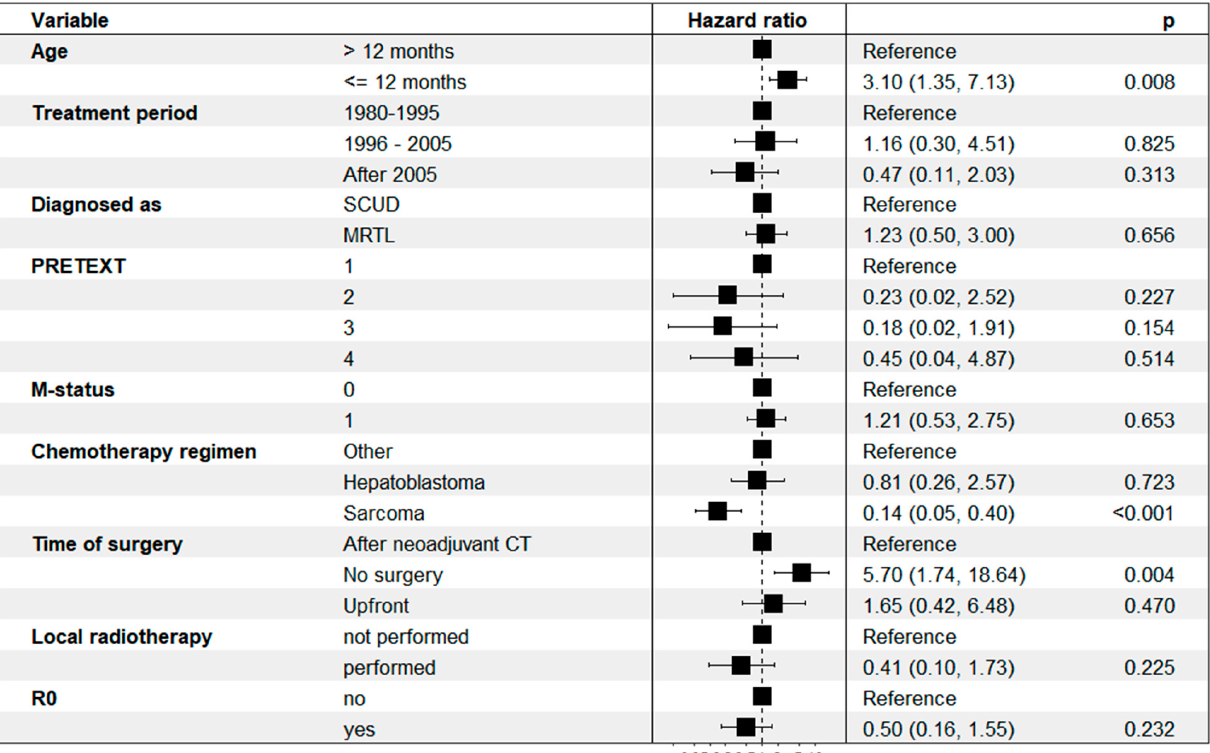
Figure 6. OS of the pooled group (MRTL and SCUD) for different surgical approaches.